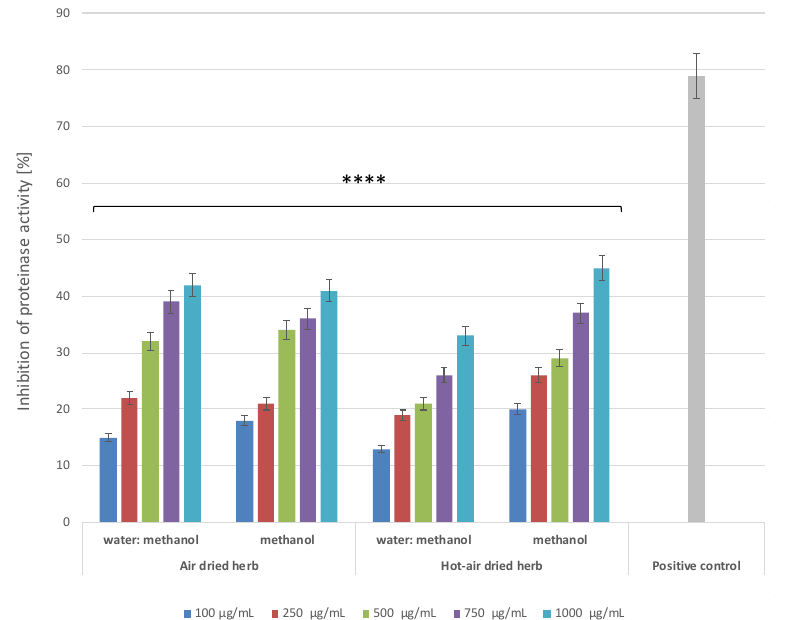
Figure 8. Proteinase inhibitory activity of B. officinalis herb extracts. Data are the means of three independent experiments. **** p < 0.0001 versus the